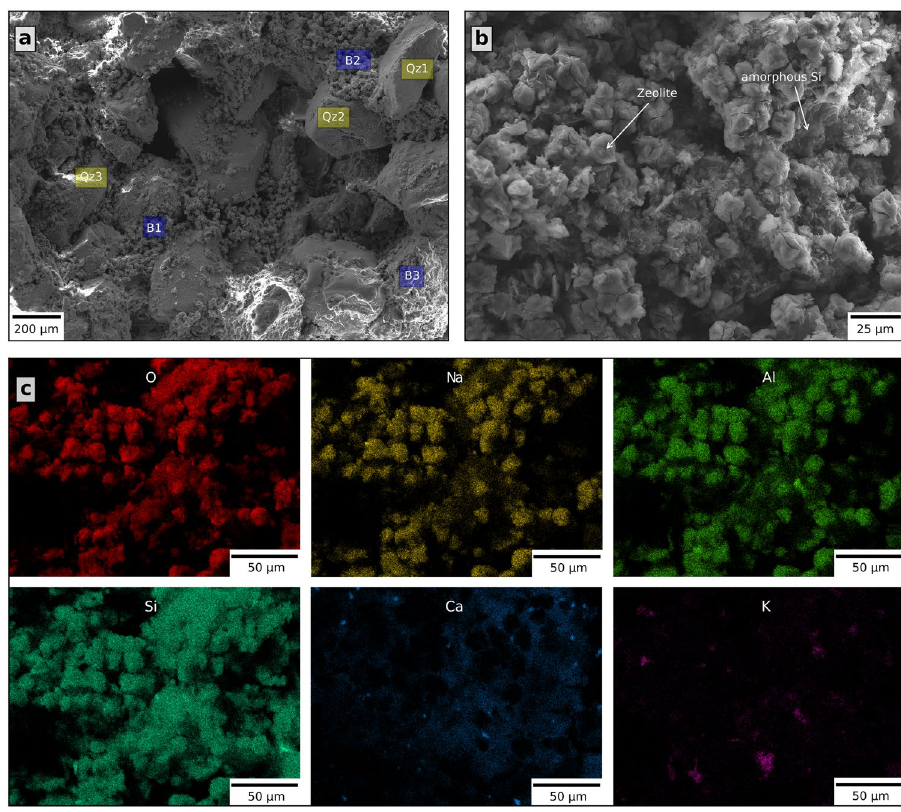
Fig. 3 a Low resolution sec- ondary electron image of the synthetic sandstone. Binder is found in intergranular regions and shows varying degrees of porosity depending on the amount of pore-filling amorphous geopolymer. The locations of quartz (Qz1-3) and binder (B1-3) EDX spot analy- ses from Table 2 are marked by blue and yellow frames. b + c Close-up and selected EDX maps showing the distribution of zeolite NaP and amorphous